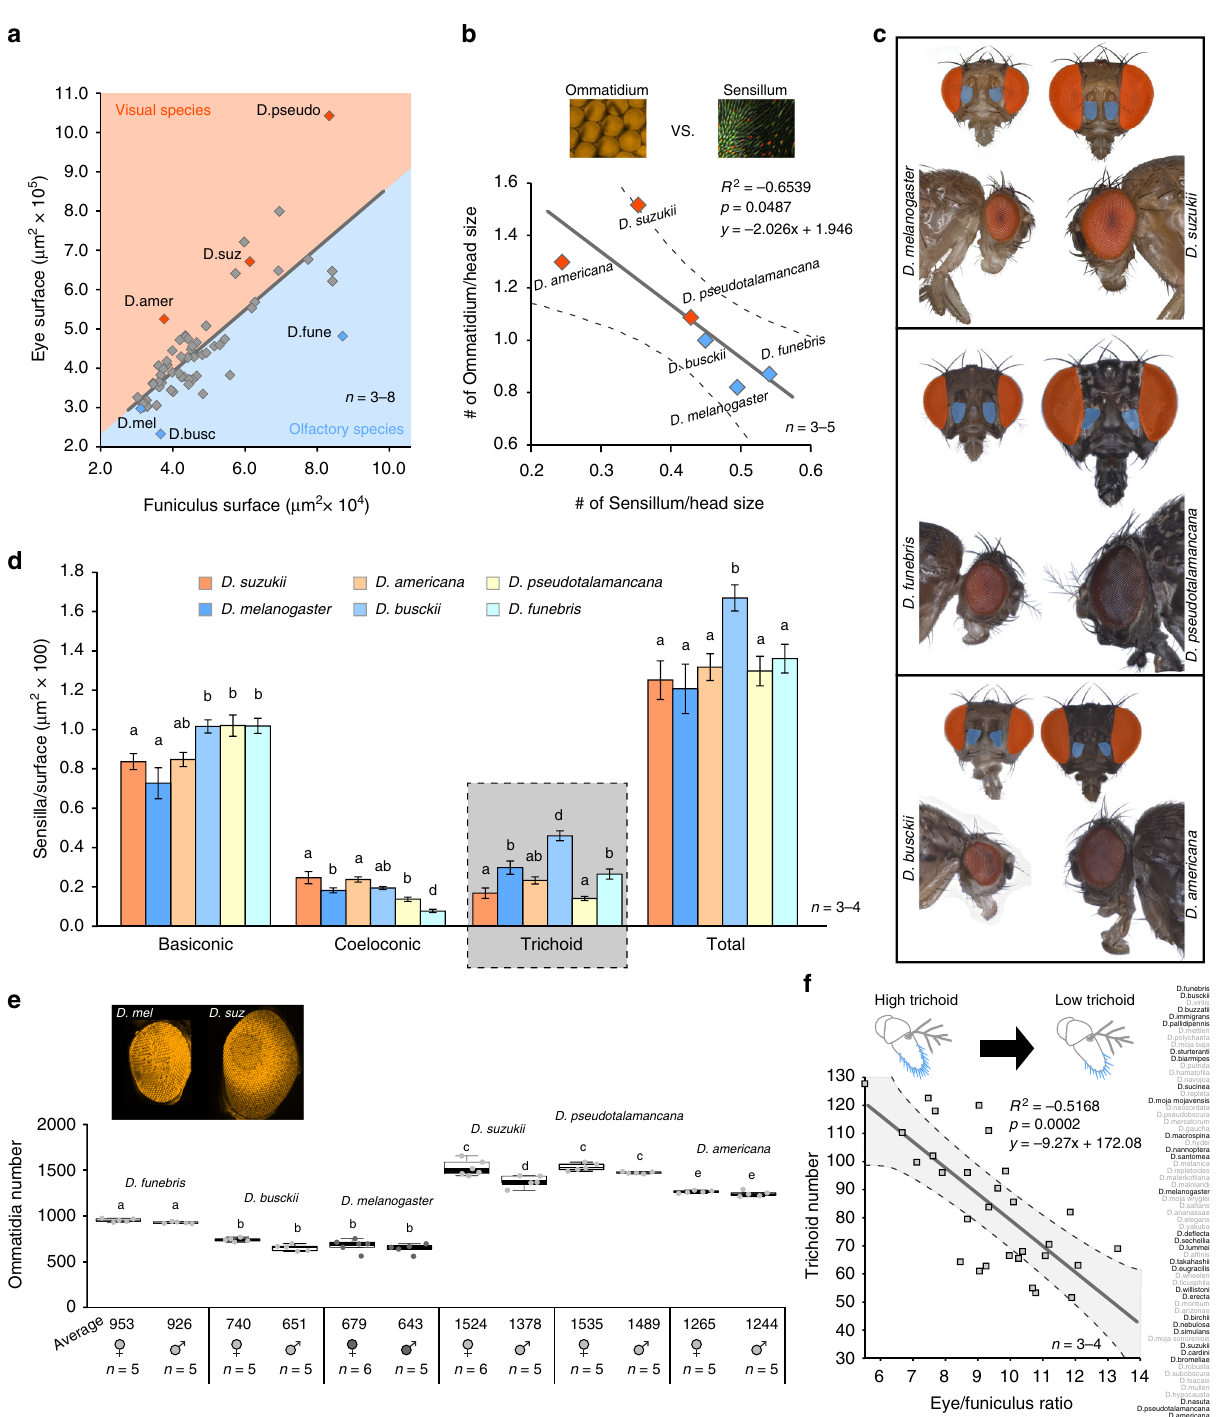
D.funebrisD.busckiiD.virilisD.buzzatiiD.immigransD.pallidipennisD.mettleriD.polychaetaD.moja bajaD.sturterantiD.biarmipesD.putridaD.hamatofilaD.navojoaD.sucineaD.repletaD.moja mojavensisD.neocordataD.pseudobscuraD.mercatorumD.gauchaD.macrospinaD.hydeiD.nannopteraD.santomeaD.melanicaD.repletoidesD.malerkotlianaD.mainlandiD.melanogasterD.moja wrygleiD.saltans D.ananassae